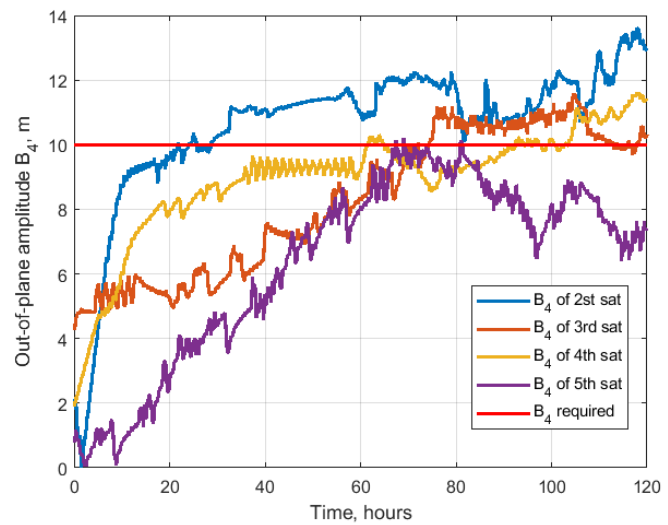
Figure 28. In-plane amplitude.